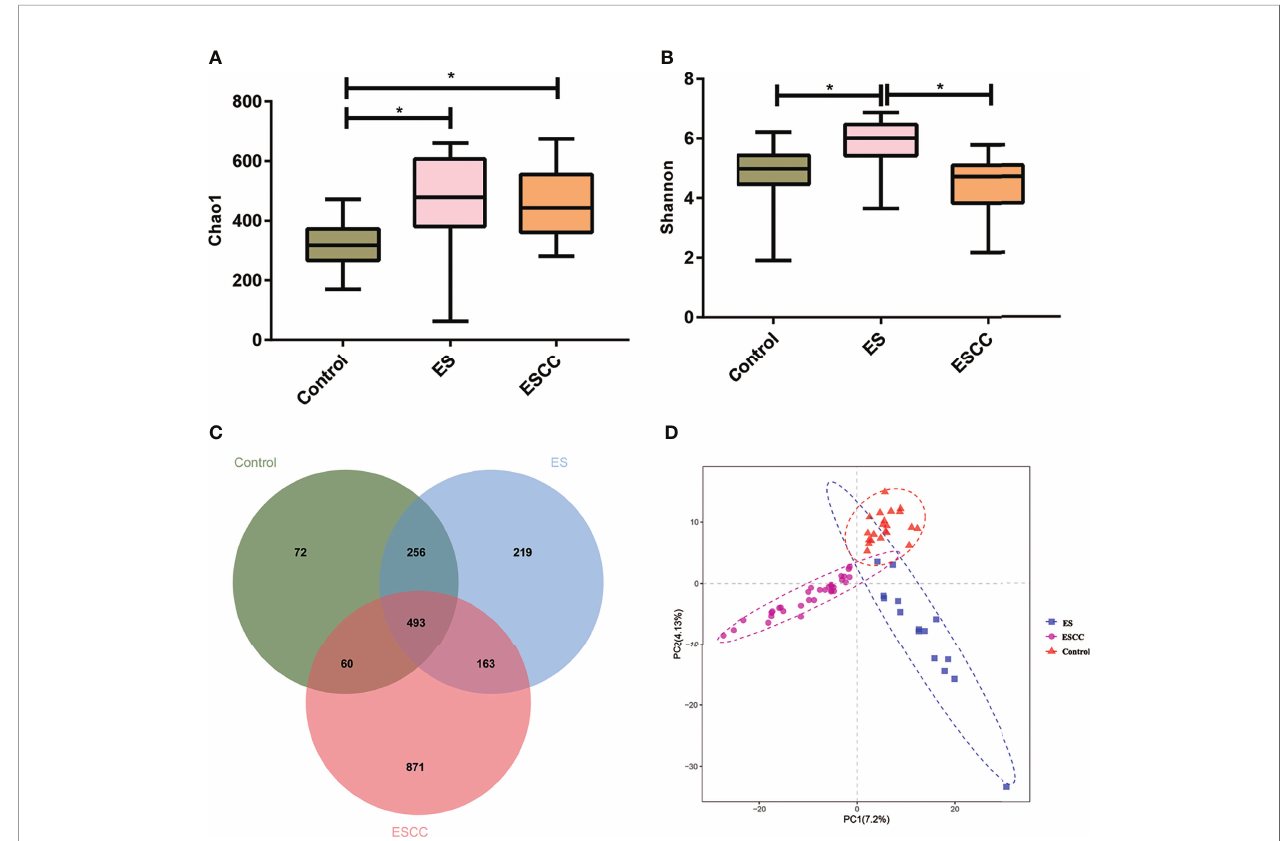
FIGURE 1 | The microbial a diversity and b diversity analysis in different groups. (A) Chao 1 index was higher in the ESCC and ES group than in the control group. (B) The ES group had a signi fi cantly higher Shannon index, in comparison with the ESCC group and control group. Data were reported as minimum (min) to the maximum (max) with the line at median. (C) A Venn diagram displayed the overlaps among the groups. (D) PLS-DA revealed different microbial community structures in the three groups. * p <